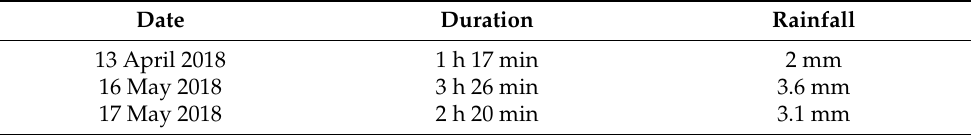
Table 1. Highway measurements (taken from [10]).